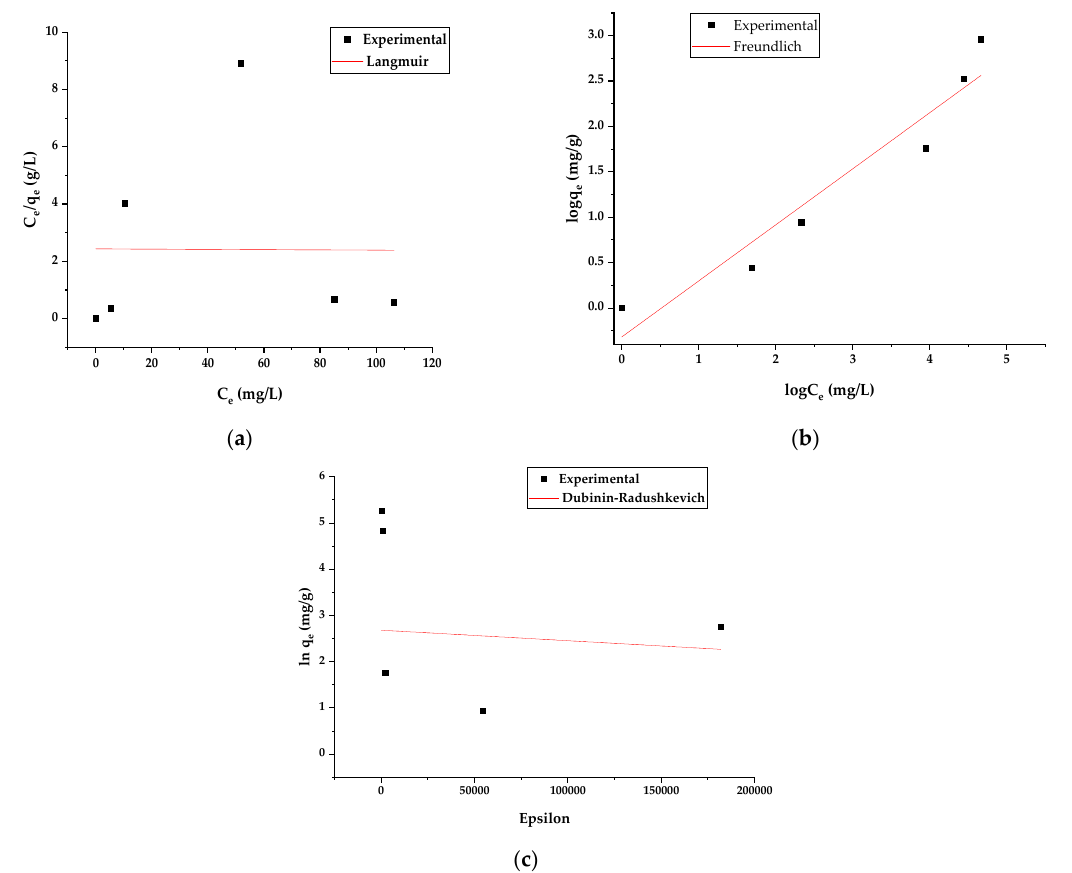
Figure 10. Linear modeling of the Cr (VI) adsorption isotherm using ( a ) Langmuir, ( b ) Freundlich and ( c ) Dubinin–Radushkevich model; at pH = 2, 55 °C and 0.14 g of adsorbent. Table 7. Modeling adjustment parameters of the Cr (VI) adsorption isotherm at pH = 2, 55 °C and 0.14 g of adsorbent.